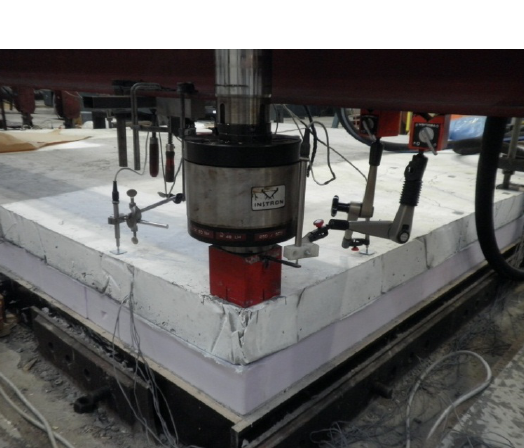
Figure 7. Test arrangement and load cell for corner load [15].